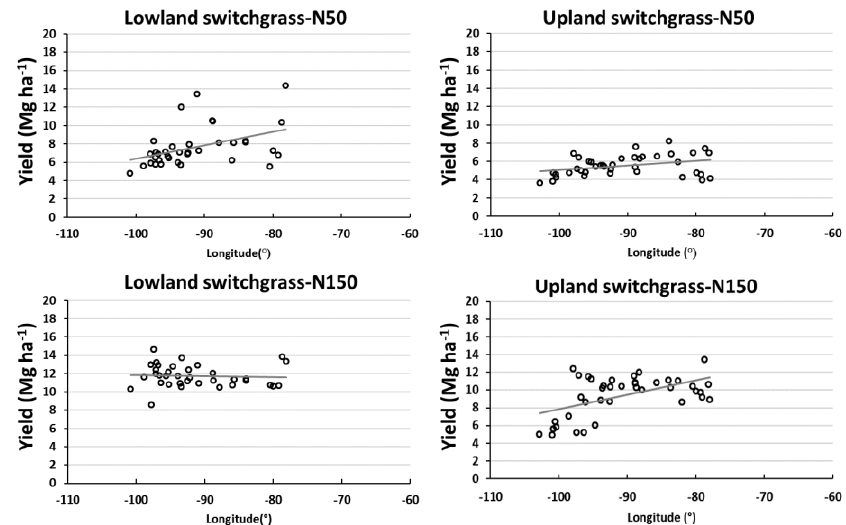
Figure 5. ALMANAC simulated yields for lowland and upland switchgrass cultivars in two different nitrogen (N) fertilizer treatments, N50 and N150 kg ha − 1 . The simulated yields were averaged over the reference period (1976–2005) from each study location. The grey solid line is the fitted regression line.